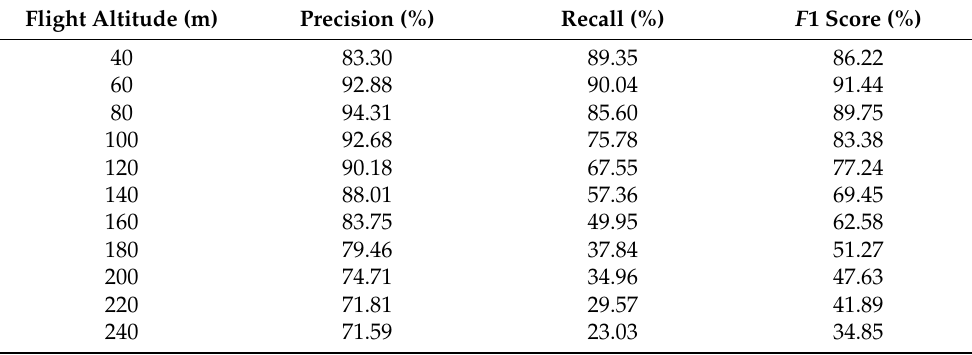
Table 8. The influence of different UAV flight altitudes on the accuracy of ITD. Flight Altitude